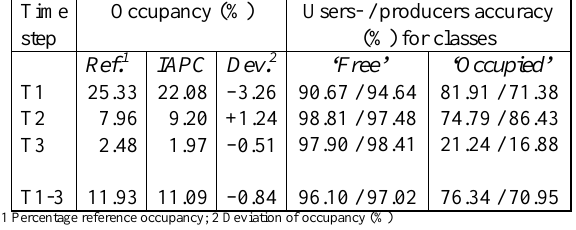
Figure 5. Web application, reference and situation view